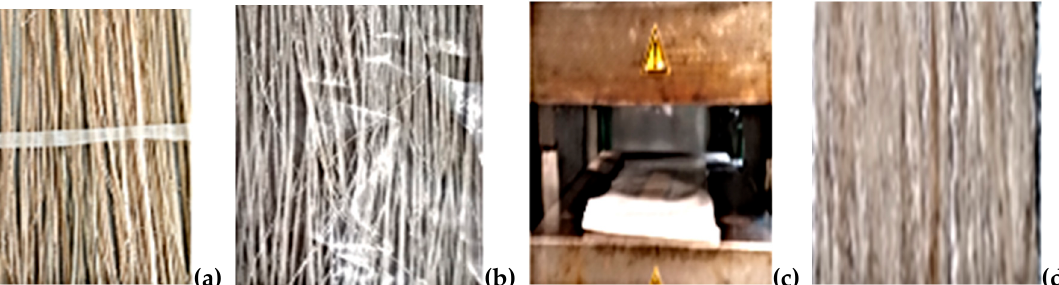
Figure 5. Preparation of the UD bamboo fibre prepregs with PP thermoplastic polymers. ( a ) Selection ( b ) Segregation ( c ) Drying ( d ) Soaking.